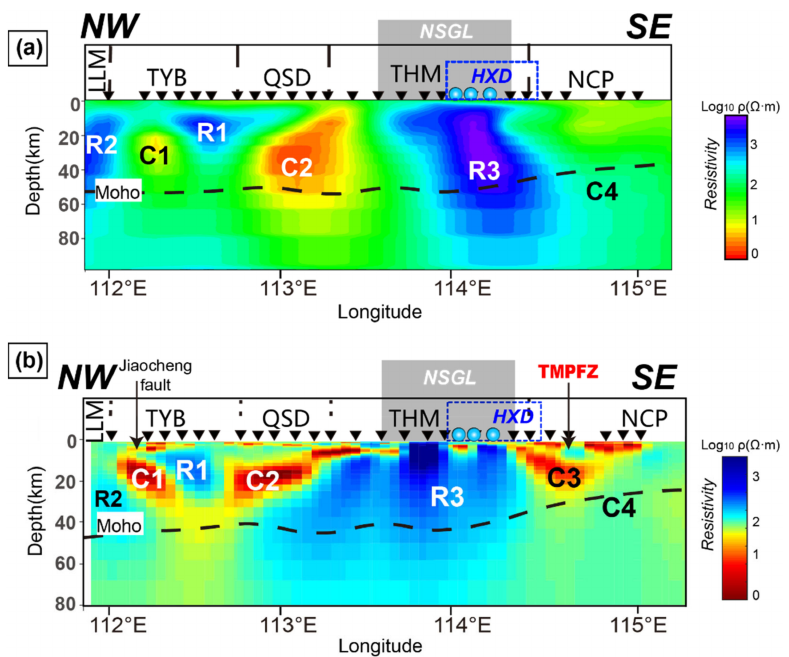
Figure 5. Vertical slices of both 2D and 3D inversion models along the transect P1 are shown in Figure 4. ( a ) 2D inversion model;( b ) 3D inversion model. Abbreviations: LLM—Lüliang Mountain; TYB—Taiyuan Basin; QSD—Qinshui Depression; THM—Taihang Mountain; NCP—North China Plain. R1–R3 represent major high-resistivity zones. C1–C4 indicates major conductors. The Moho depth was plotted according to a previous seismic survey